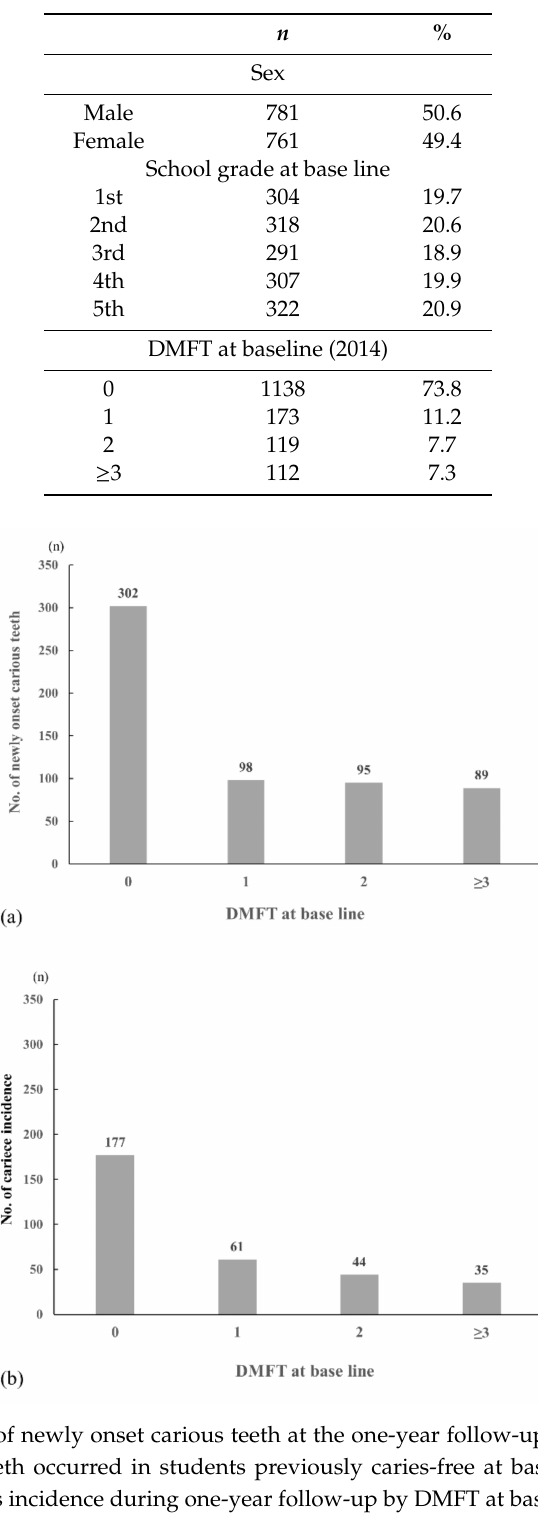
Table 1. Characteristics of participants ( n = 1542). MDFT: decayed, missing, and filled teeth.